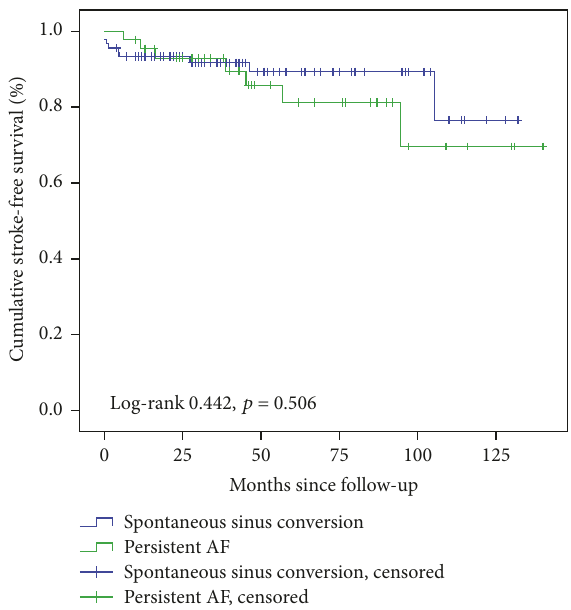
Figure 3: Stroke free survival in patients with thyrotoxic atrial